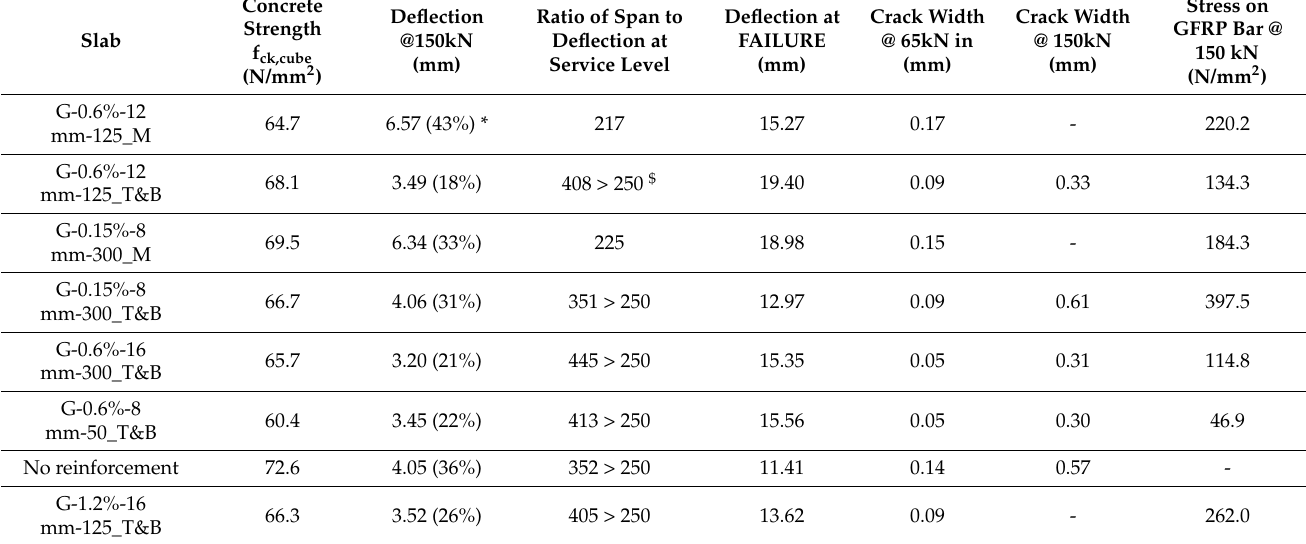
Table 2. Deflection and crack width expansion of the slabs at different load levels.